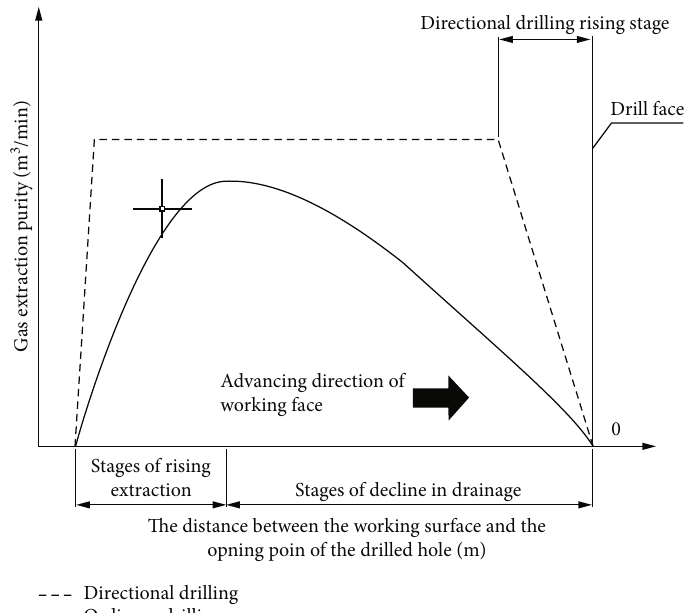
Figure 2: The relationship between the extraction volume of the high-level drilling in the roof and the advancing distance of the working